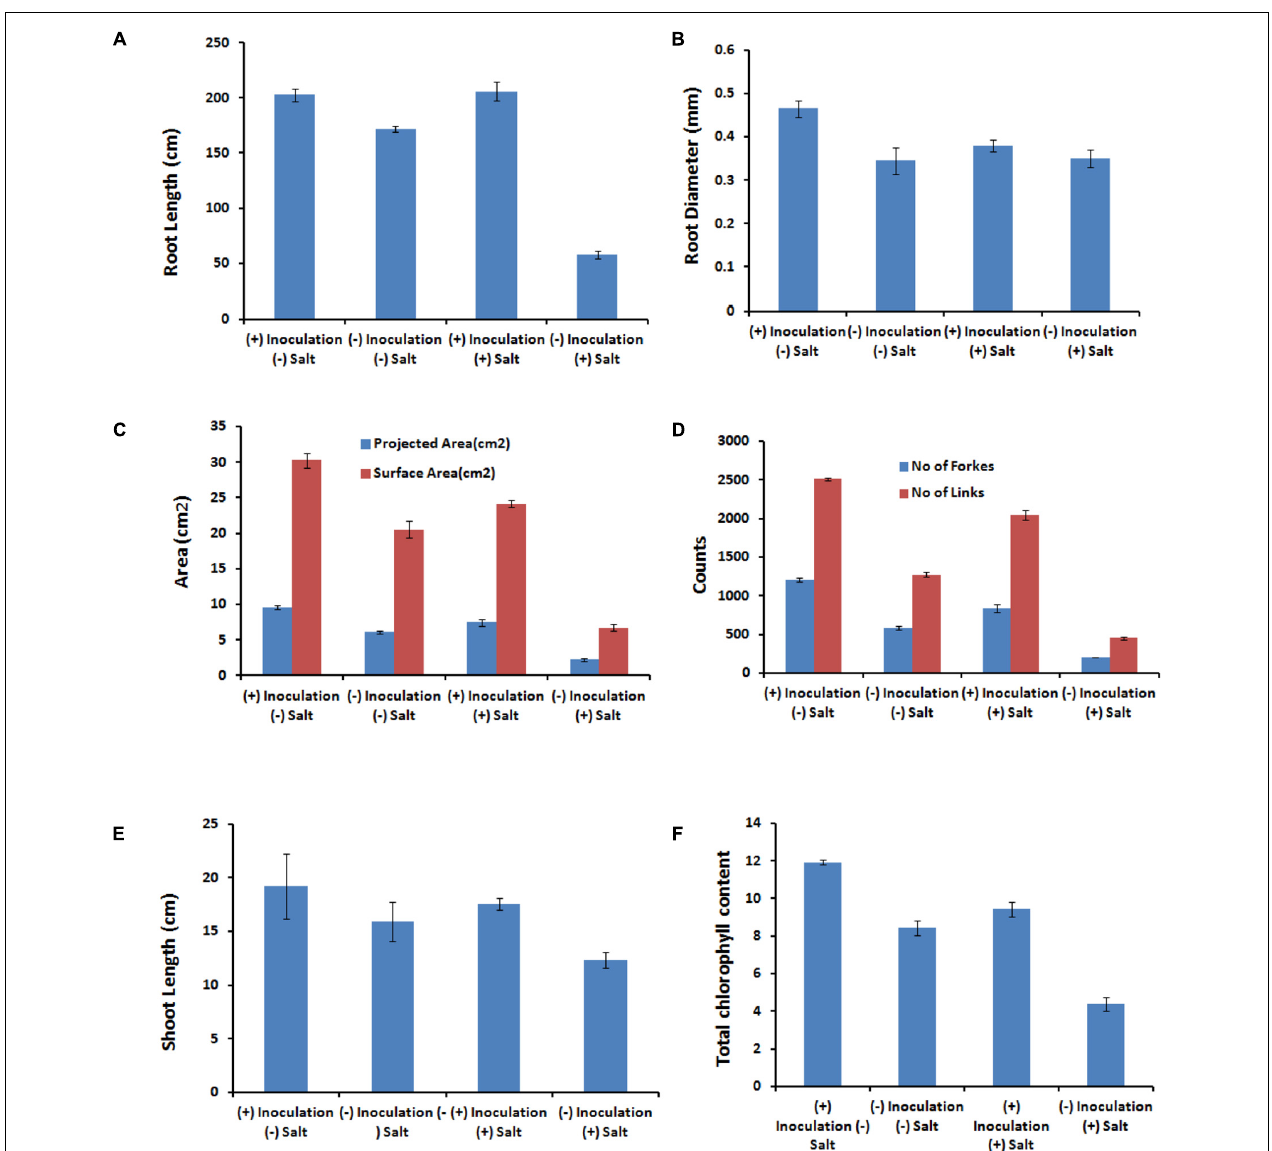
FIGURE 6 | Statistical analysis of the several parameters. (A) Represents the root length, (B) represents the root diameters, (C) represents the projected and surface area, (D) represents the number of forks and links, (E) represents the shoot length, and (F) represents the total chlorophyll content in different conditions as represented in the figure like in the presence (100 mM NaCl) and absence of salt either treated with PHM11 or